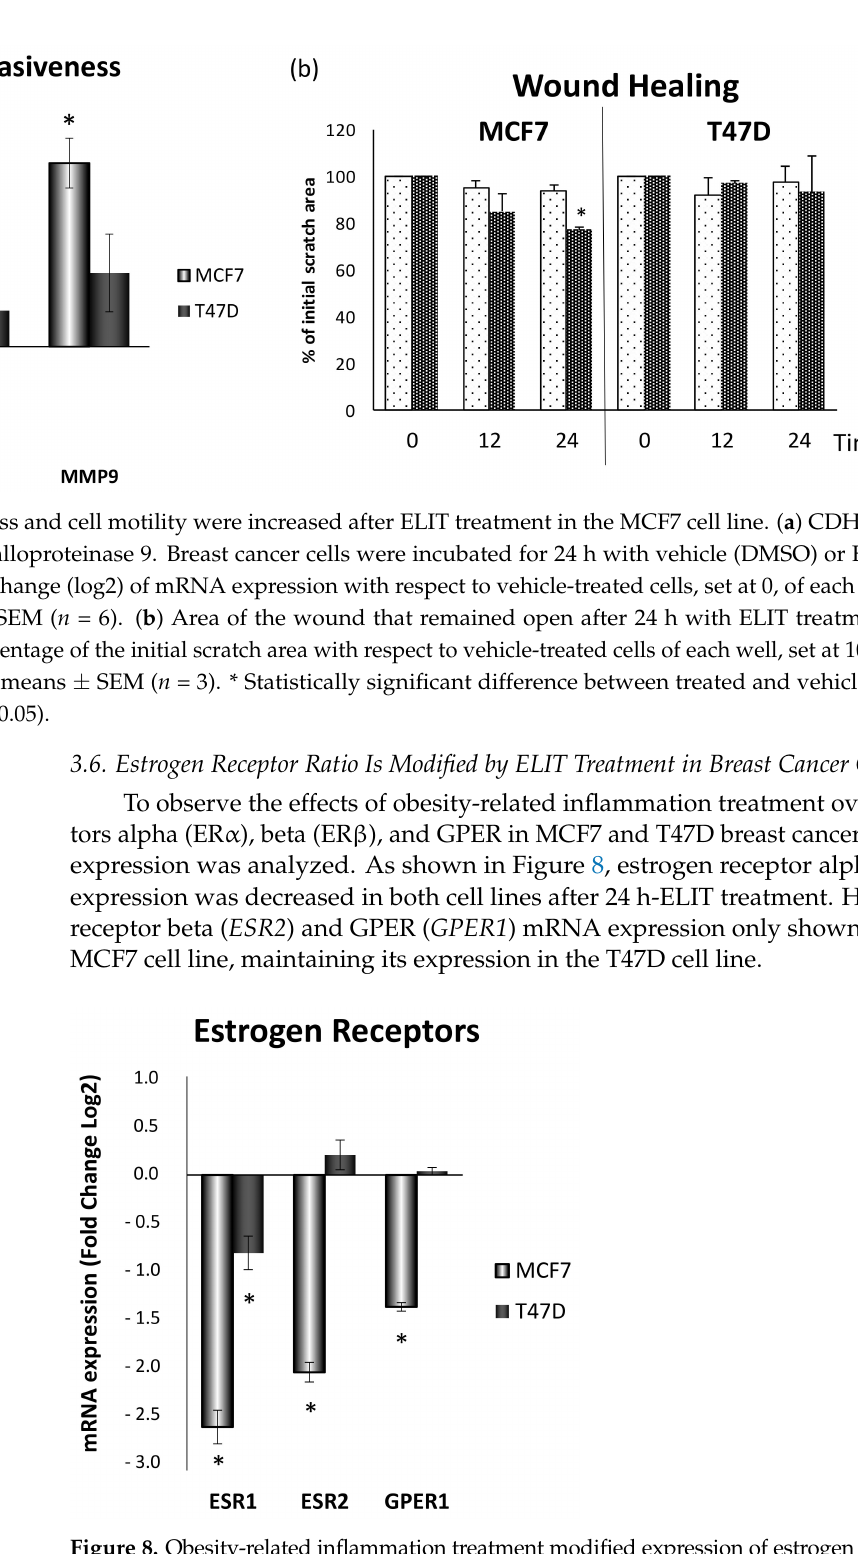
Figure 8. Obesity-related inflammation treatment modified expression of estrogen receptor alpha, beta, and GPER in MCF7 and T47D breast cancer cell lines. ESR1 : estrogen receptor alpha; ESR2 : estrogen receptor beta; GPER1: G-coupled protein estrogen receptor. Breast cancer cells were incubated for 24 h with vehicle (DMSO) or ELIT. Data are represented as fold change (log2) of mRNA expression with respect to vehicle-treated cells, set at 0, of each cell line. Data represent means ± SEM ( n = 6). * Statistically significant difference between treated and vehicle-treated cells (Student’s t -test, * p <